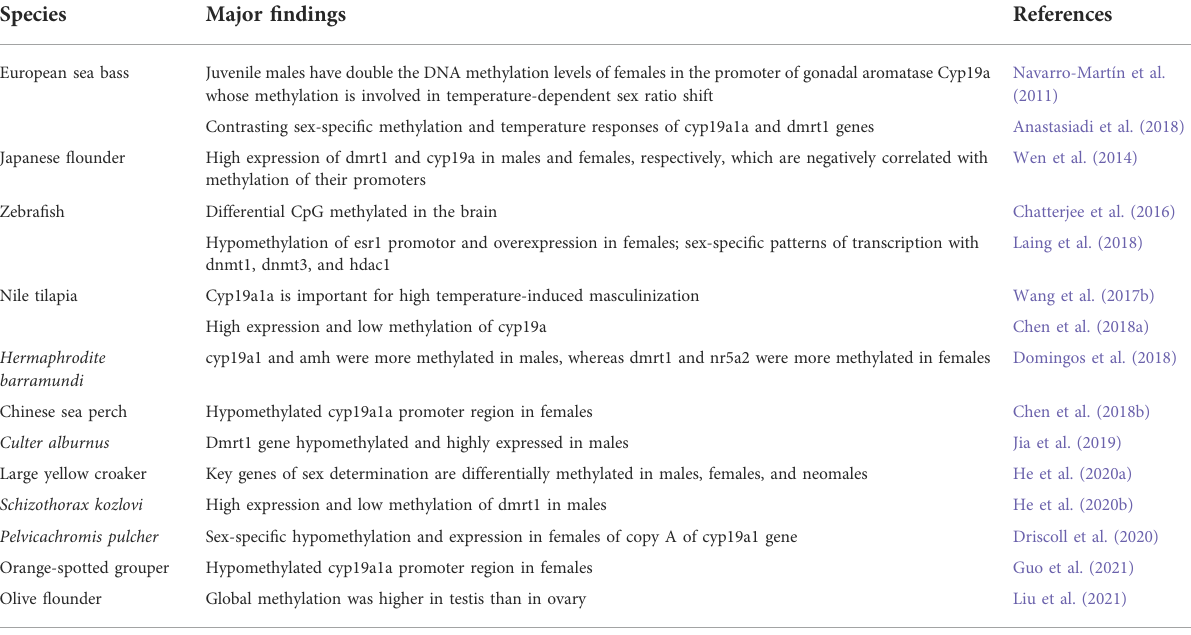
TABLE 5 Differential DNA methylation of key genes involved in sex determination and/or differentiation. Species Major fi ndings